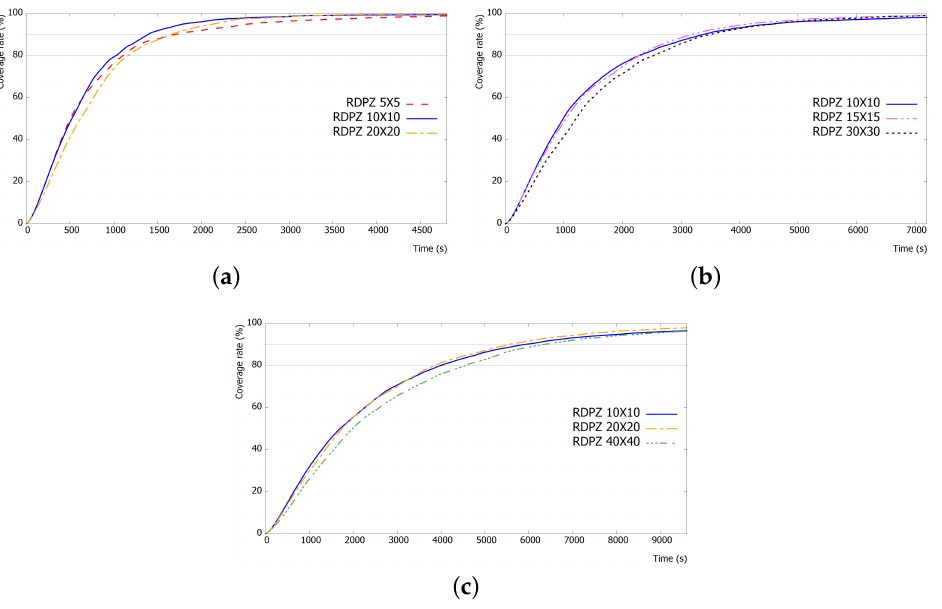
Figure 11. The coverage rate results: ( a ) 20 km × 20 km area; ( b ) 30 km × 30 km area; and ( c ) 40 km × 40 km